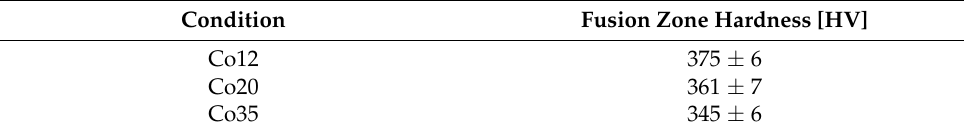
Table 3. Volume fractions for all the conditions.